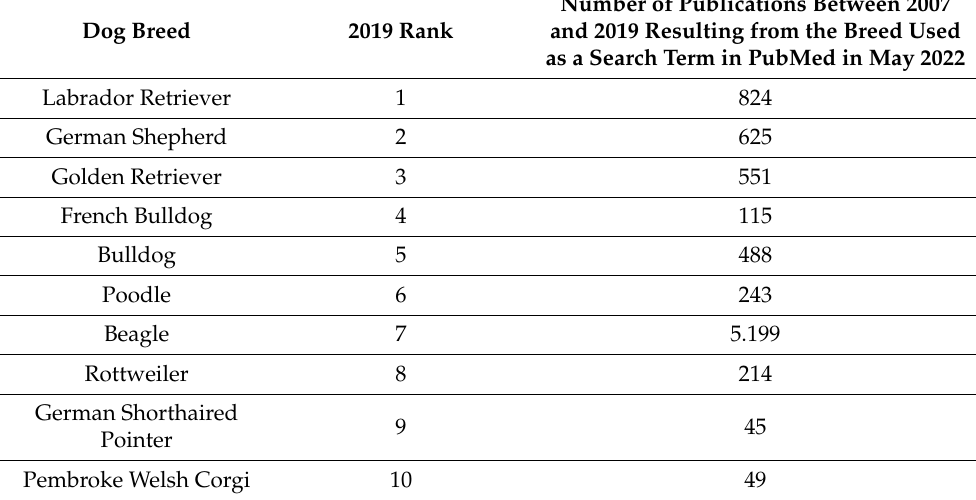
Table 1. Top 10 dog breeds in the US in 2019 and the number of publications found in PubMed for each breed (search date: 21 May